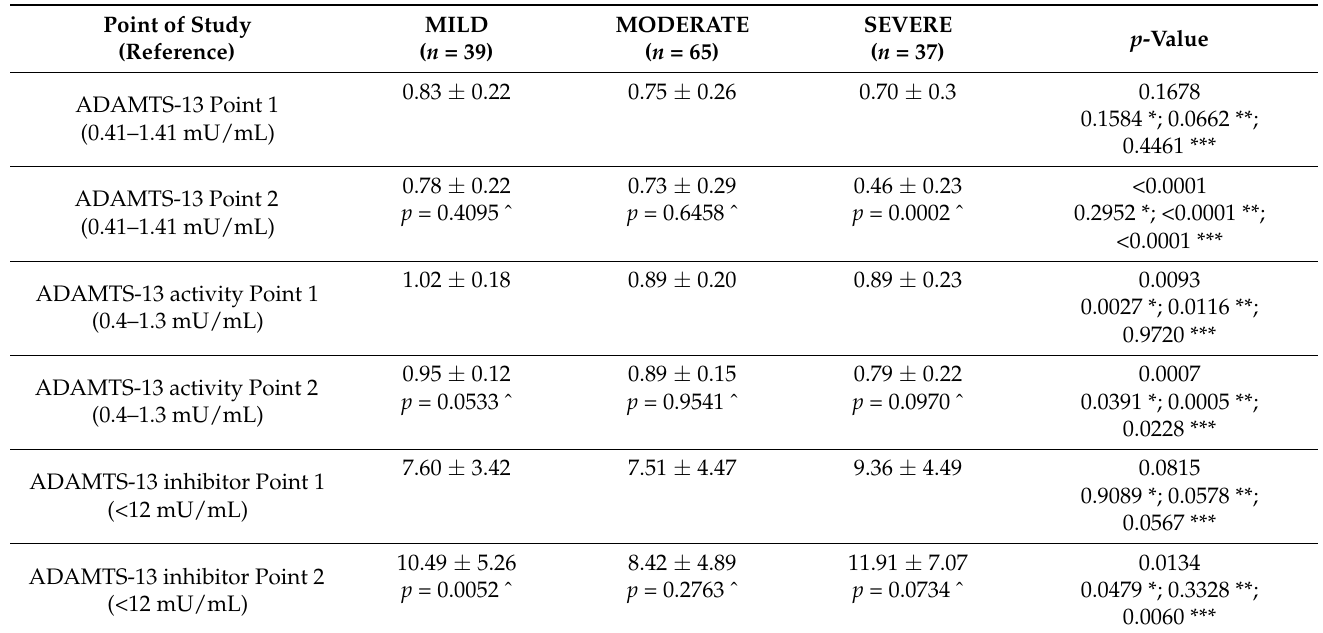
Table 2. The blood concentration and activity of ADAMTS-13 and the blood concentration of the ADAMTS-13 inhibitor in patients COVID-19.